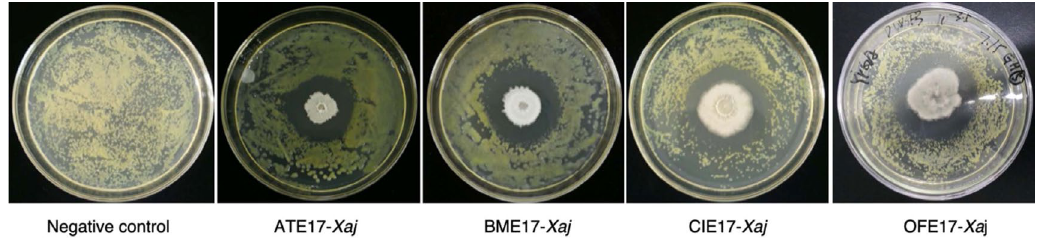
Fig. 1. Antagonistic effects of four endophytes against Xaj DW3F3 on YPGA